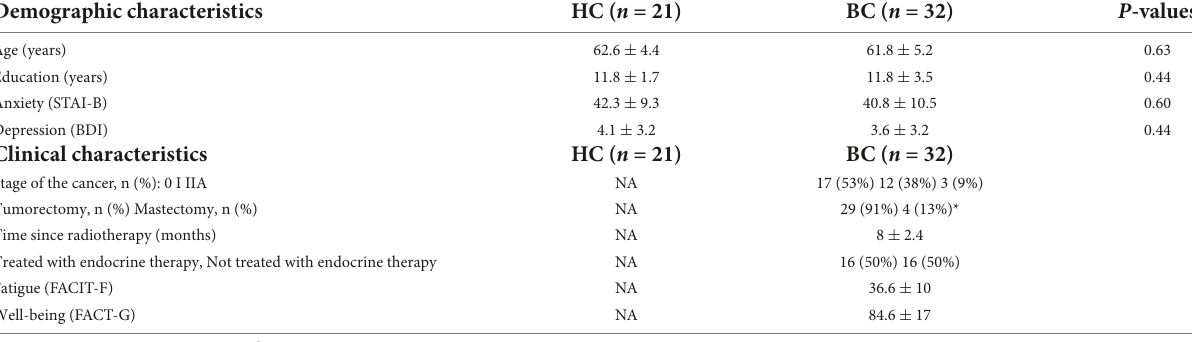
TABLE 1 Demographic and clinical characteristics of participants (mean ± SD).